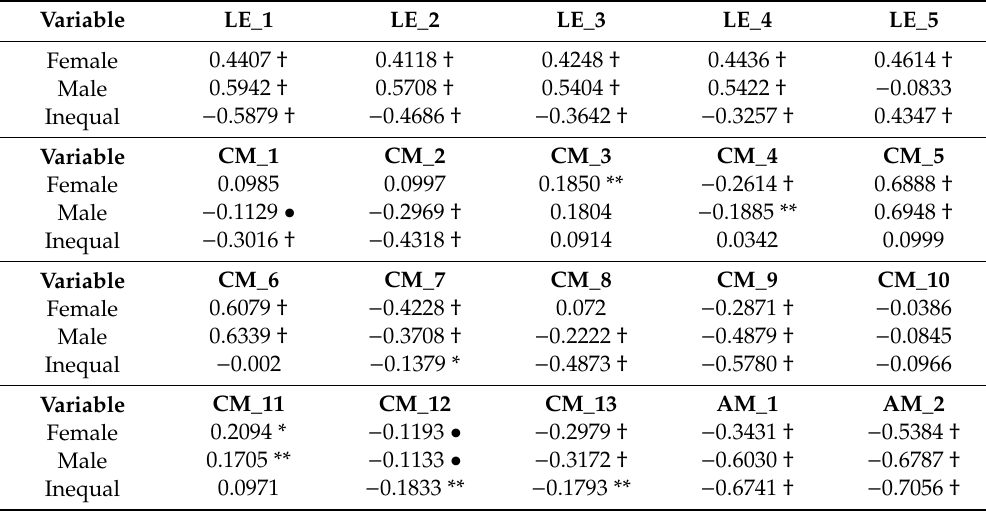
Table 3. Correlation analysis